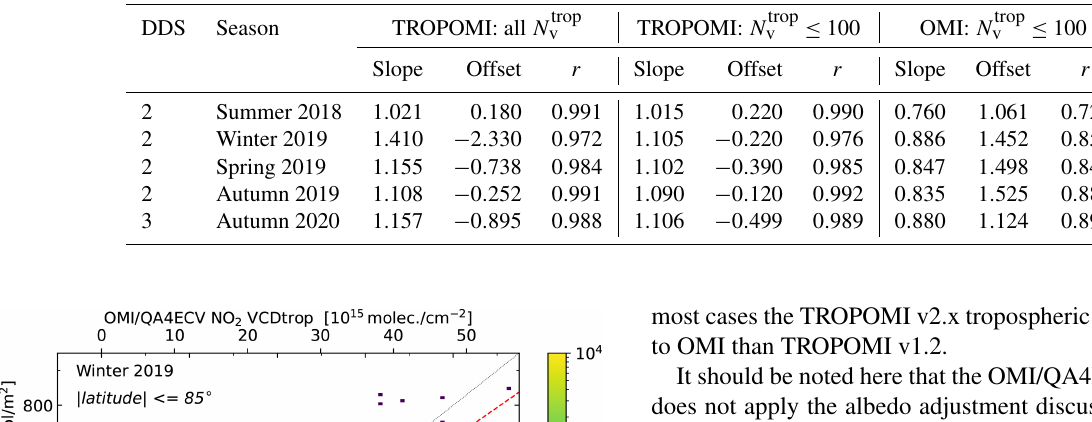
Table 5. Results of linear fit and correlation coefficients ( r ) of scatter plots of gridded NO 2 tropospheric VCD ( N trop v ) averaged over the VCD part of the DDS periods using ground pixels with cloud radiance fraction w c < 0 . 50 and latitude ≤ 85 ◦ . TROPOMI v1.x or OMI/QA4ECV data are along the x axis, and TROPOMI v2.x is along the y axis; the offset, given in µmolm − 2 , is much smaller than typical column values. The first set of TROPOMI data uses grid cells with all N trop v values, while the second set and the OMI set use only grid cells with N trop v ≤ 100µmolm − 2 .